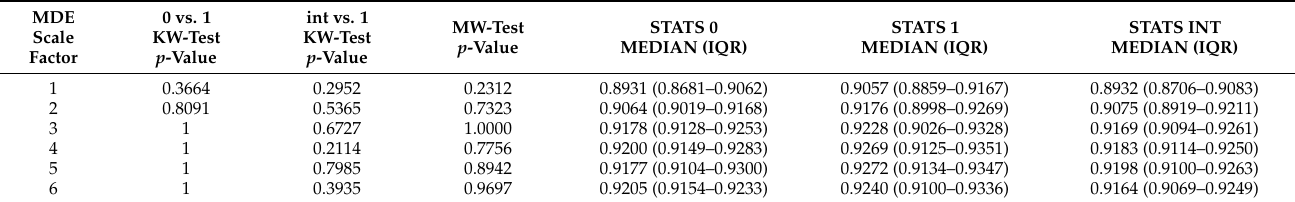
Table 6. Multiscale Distribution Entropy—statistical results of the test described in Section 2.6. The descriptive statistics (median and IQR) related to the three groups considered (0, 1, and int) are reported. MDE Scale